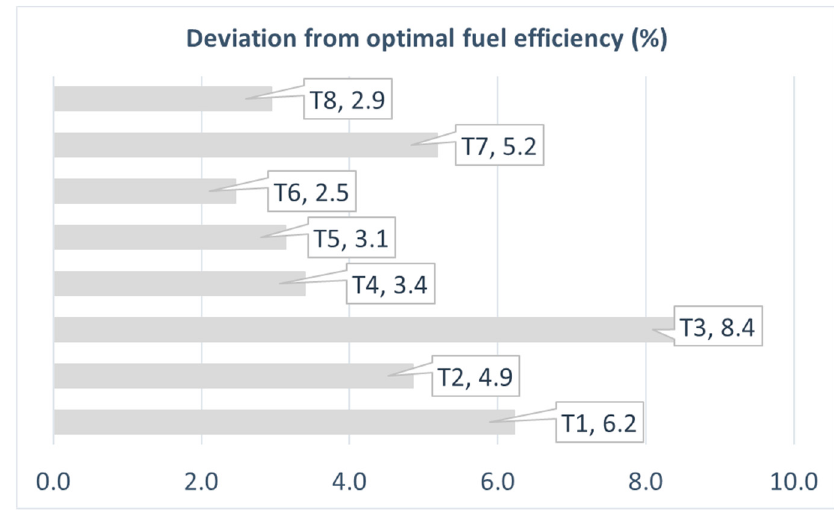
Figure 13. Technology sensitivity analysis: deviation from optimal fuel efficiency target value.